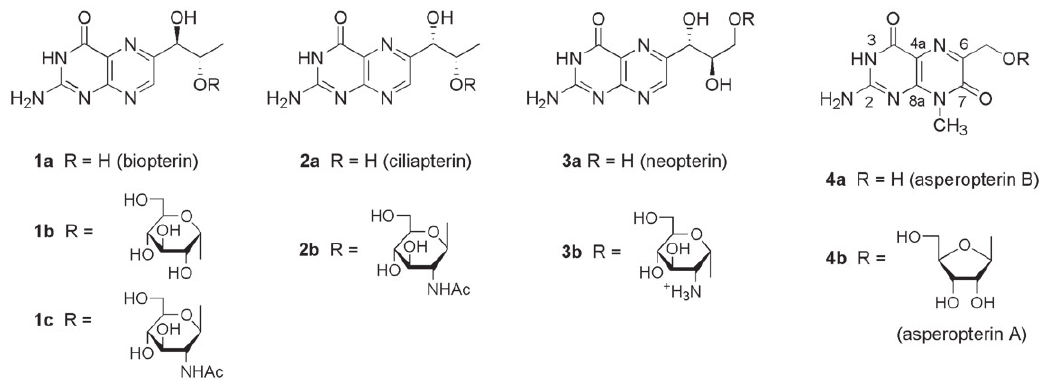
Figure 1 Naturally occurring pterin